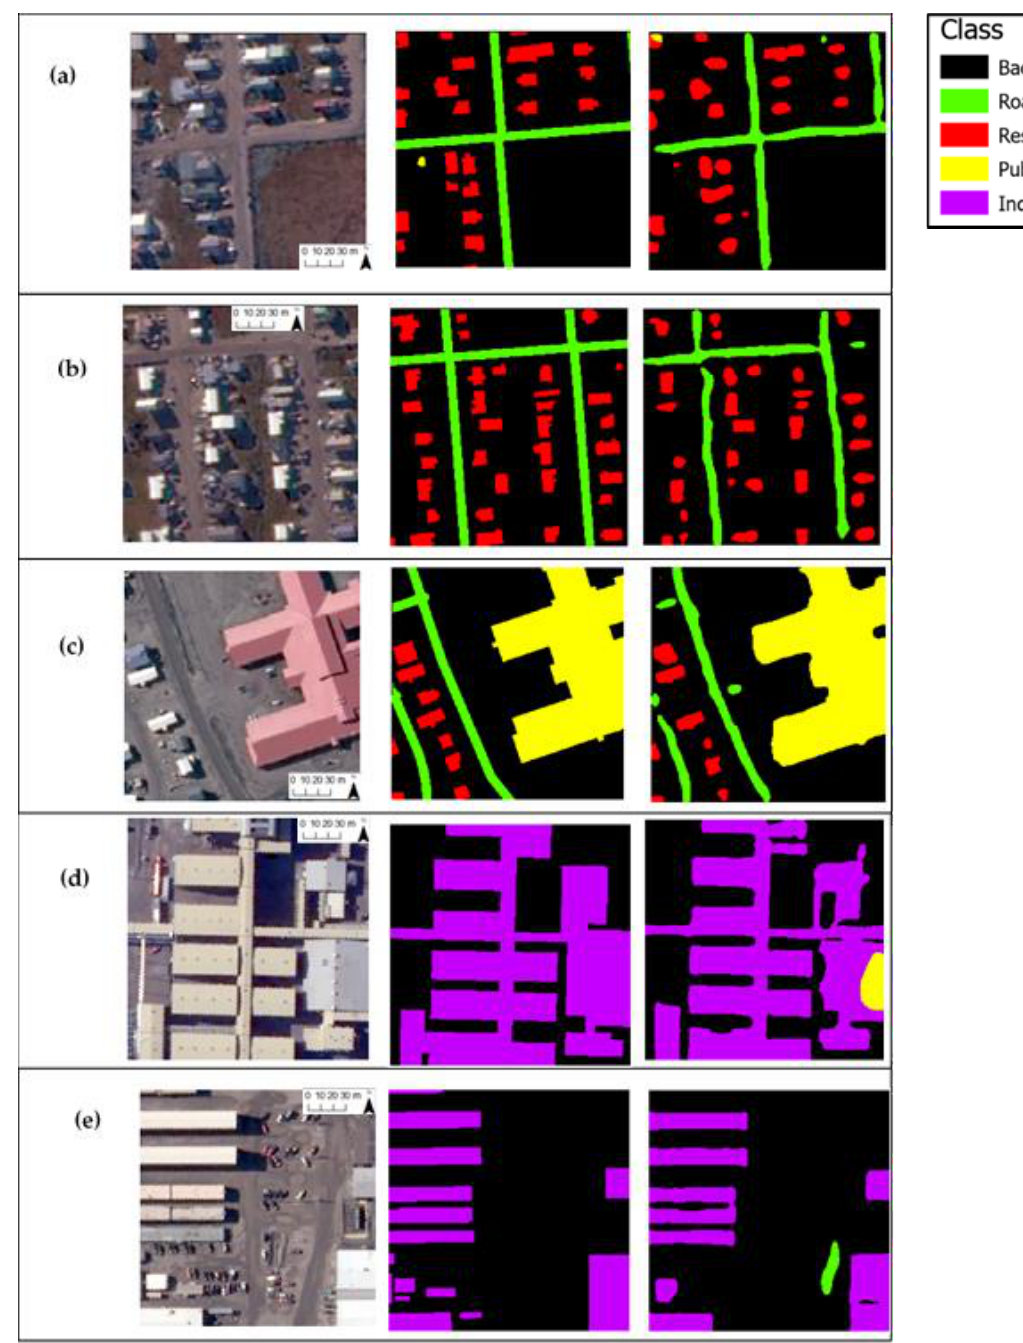
Figure 7. Selected model predictions on the testing dataset from the Utqiagvik and Prudhoe Bay sites. ( a–e ) each contain the input image tile, annotated image tile showing true output, and output predicted by the model from left to right. Imagery © DigitalGlobe,